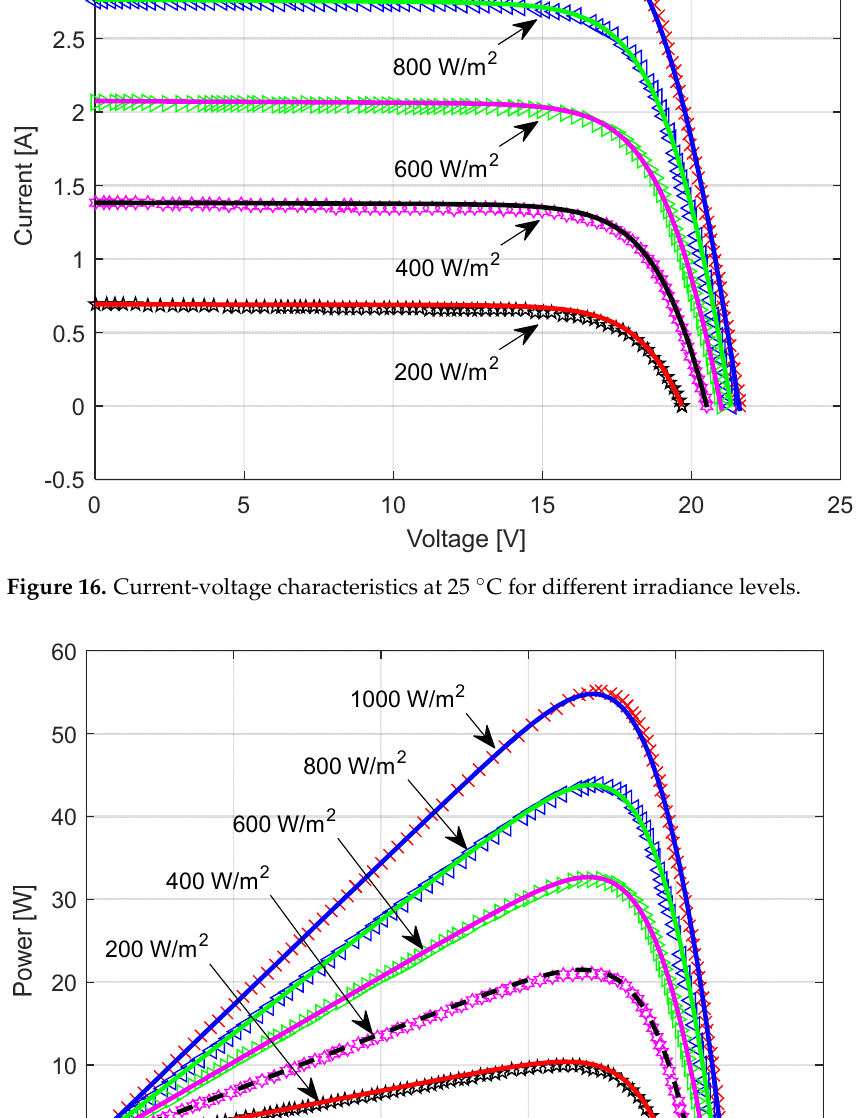
Figure 15. Power-voltage characteristics at 1000 W/m 2 and 25 °C.